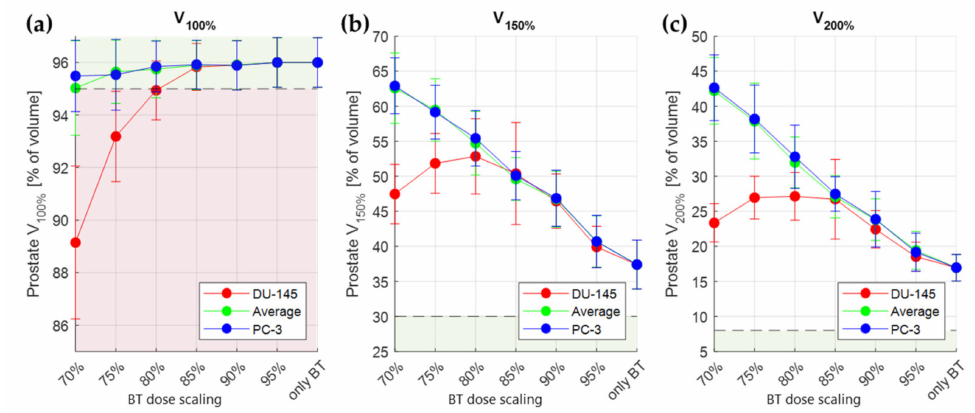
Figure 7. Average values ( ± standard deviation) over 10 simulated patients of TBT prostate V 100% ( a ), V 150 % ( b ), and V 200% ( c ) for different scalings of the original HDR-BT dose. The different colors correspond to the plans generated based on different thermoradiotherapeutic values (red for DU-145, blue for PC-3, and green for the average between DU-145 and PC-3). It is evident that the original prostate coverage is met when the physical dose is scaled over 80% of the original value. The vertical bars correspond to standard deviation. The horizontal dashed lines correspond to the objective ( V 100% ) and soft constraint ( V 150 % and V 200% ) limits. The green and red areas correspond to targeted and constrained values, respectively.